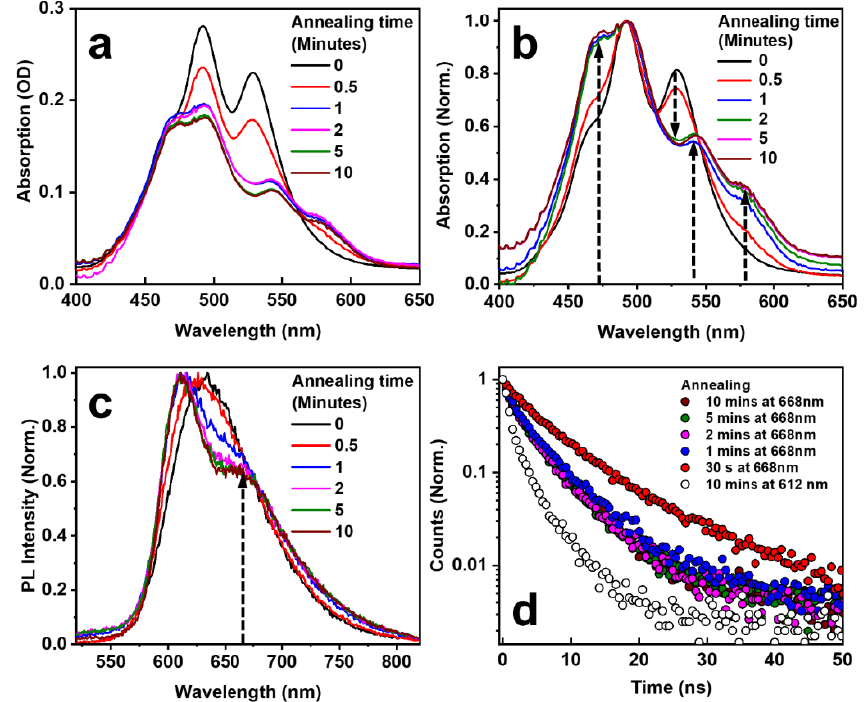
Figure 5. Absorption ( a , b ) and PL ( c ) spectra of the blend film annealed at 150 ◦ C for different annealing times. ( b ) A normalized replot of ( a ). ( d ) Emission decay dynamics at 668 nm for different annealing times of 0.5, 1, 2, 5, 10 min and a comparison with that at 612 nm for an annealing time of 10 min.